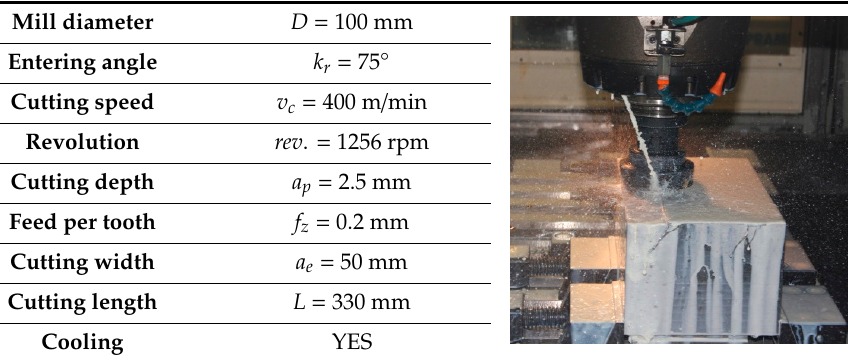
Table 6. Face milling conditions and parameters.